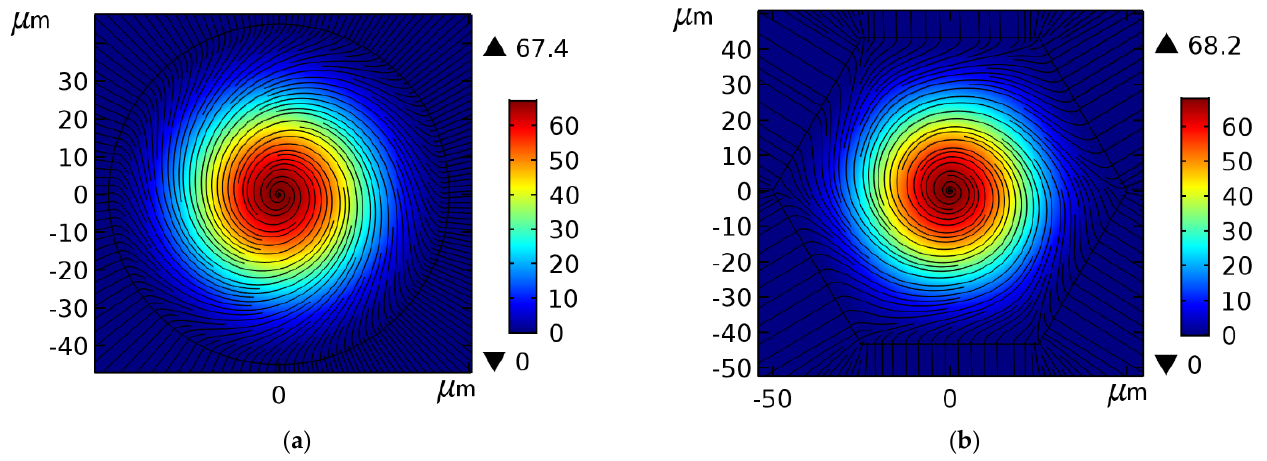
Figure 2. Axial component of the Poynting vector (in color) and the streamlines of transverse component of the Poynting vector of fundamental air core modes (HE 11 ) (black lines) at a wavelength of 3.39 µm: ( a ) air hole in an infinite layer of dielectric (refractive index n = 1.45) with an air core diameter of D = 90 µm; ( b ) air core hexagon in an infinite layer of a dielectric (refractive index n = 1.45) with the same effective mode area of the fundamental air core mode as the one shown in ( a ).